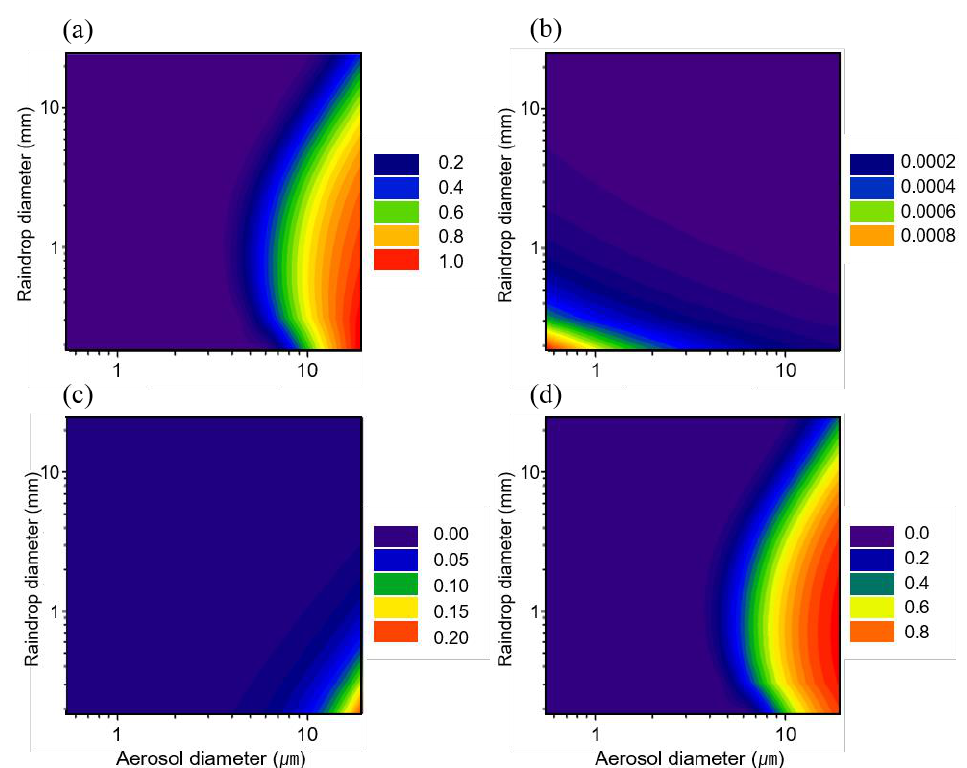
Figure 4. Distribution of ( a ) collision efficiency, ( b ) Brownian diffusion, ( c ) interception, and ( d ) impaction as a function of aerosol and raindrop diameters.